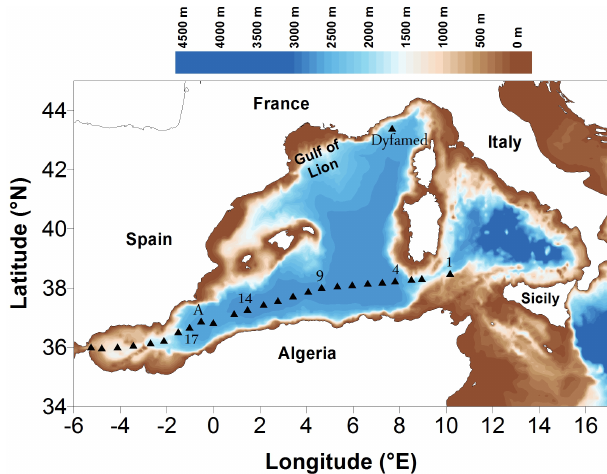
Figure 1. Map of hydrographic stations in the western Mediter- ranean Sea that are used here to examine the processes leading to long-term changes in deep Mediterranean temperature and salinity. Here we focus on long-term (1961–2008) changes in temperature and salinity of the Mediterranean waters at location A at the eastern entrance to the Alboran Sea and on recent (2004–2013) changes at station 9. Stations 4 to 17 were used by Bryden et al. (2014) to es- timate downward heat, salt and density fluxes into the deep water. Also indicated is the DYFAMED station with monthly time series temperature and salinity profiles extending back to 1991.